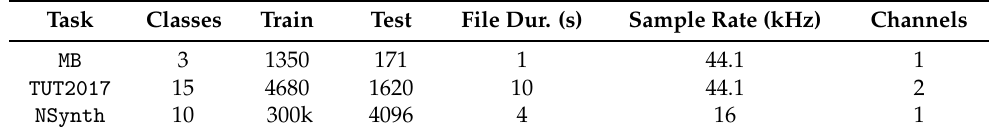
Table 1. Dataset details including the number of classes, total amount of files for training and testing, the file duration (File dur.) of each audio recording, the sample rate, and the number of channels of the audio